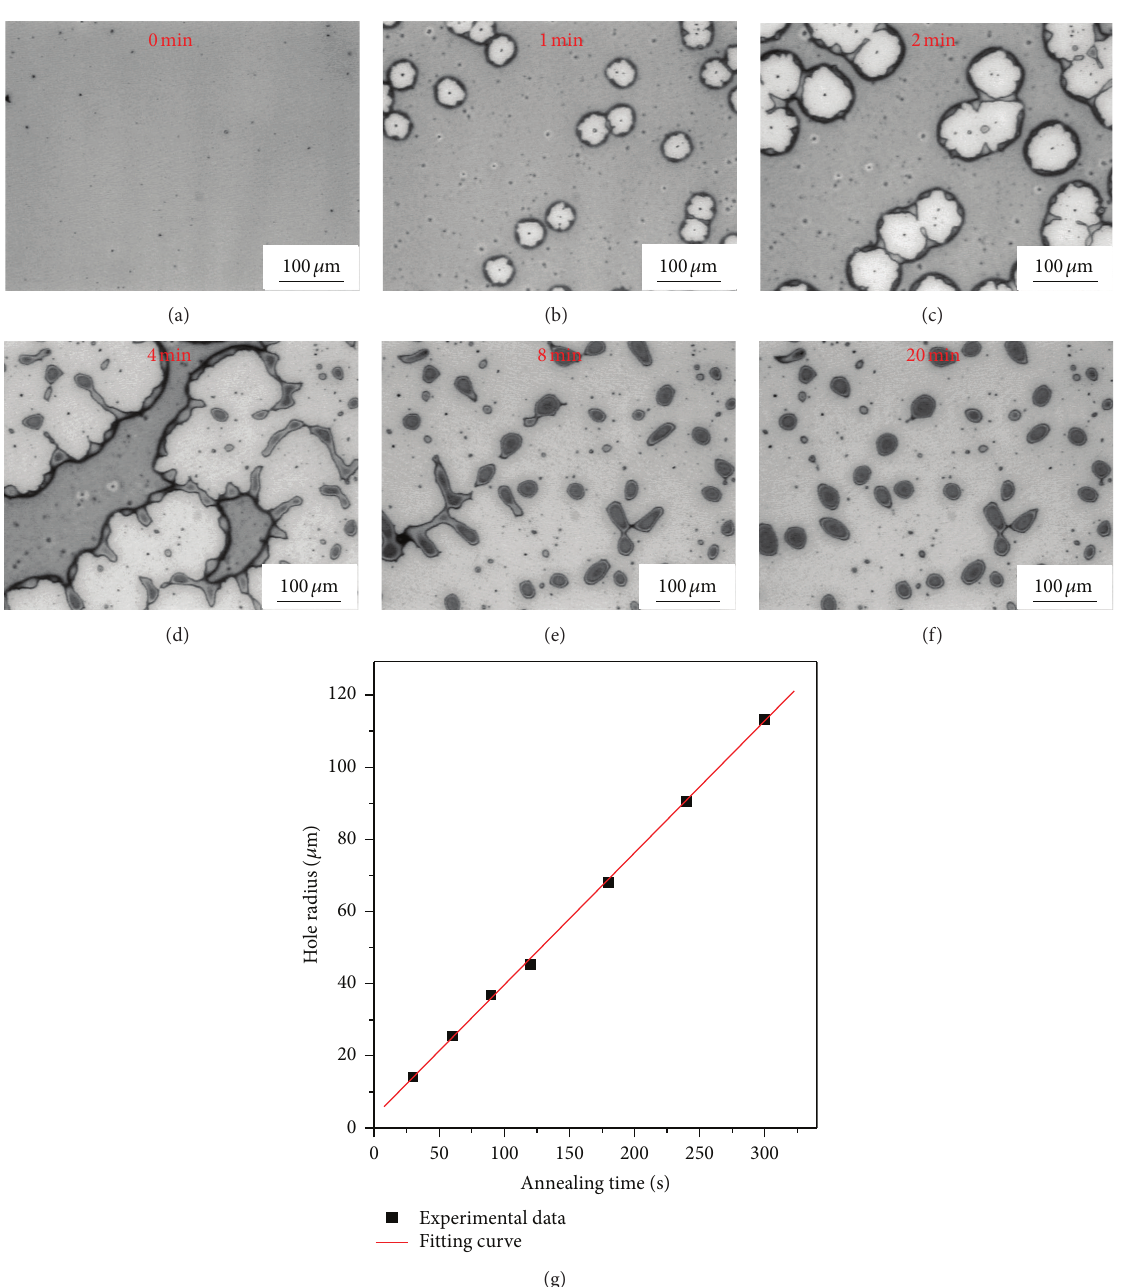
Figure 1: Optical micrographs of a PEO- b -PS film with initial thickness of 43.9 nm annealed at 393 K for (a) 0min, (b) 1min, (c) 2min, (d) 4min, (e) 8 min, and (f) 20min. And (g) radius of hole as a function of annealing